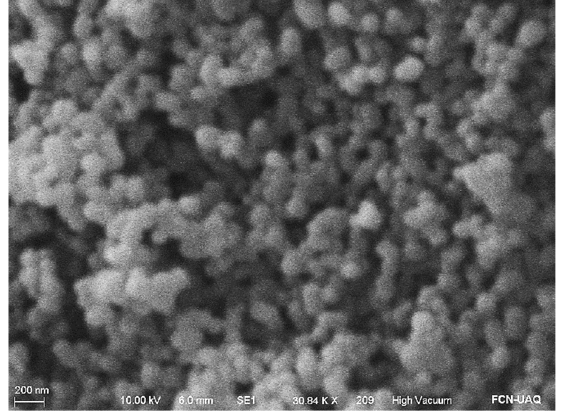
Figure 1. Scanning electron micrograph of amino-functionalized MSN (A-MSN). Amplification ≈ 30